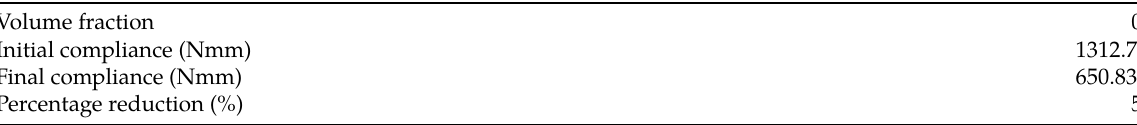
Table 2: Result obtained for topological